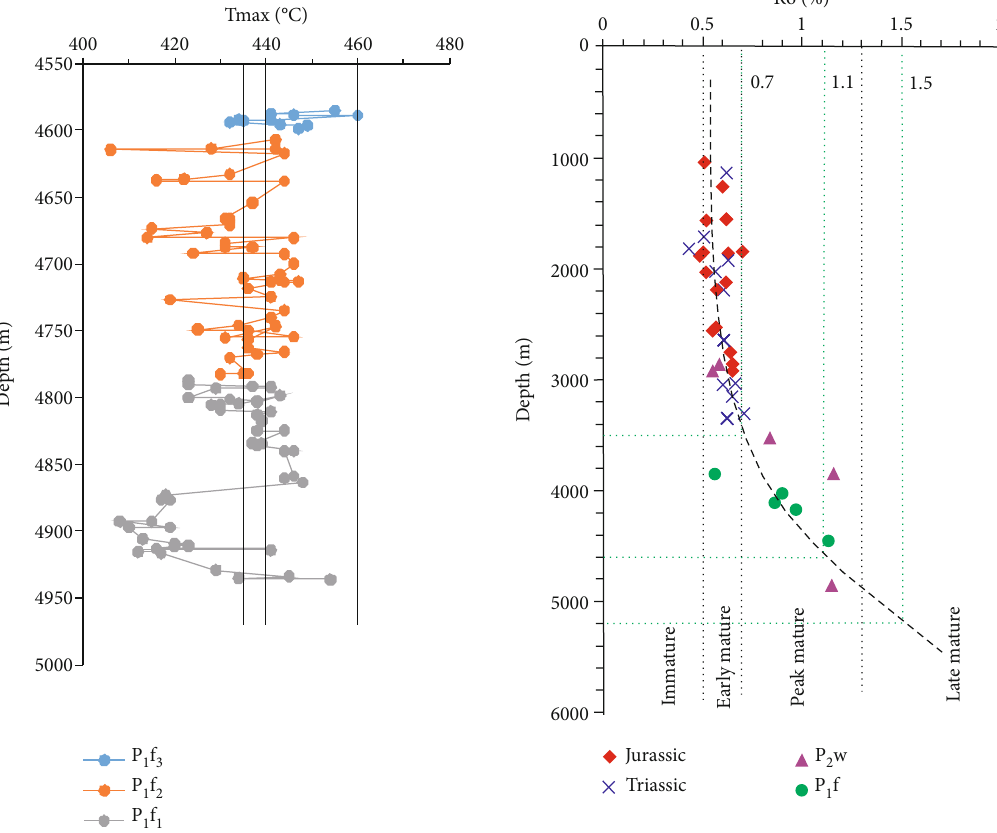
Figure 9: Change of T